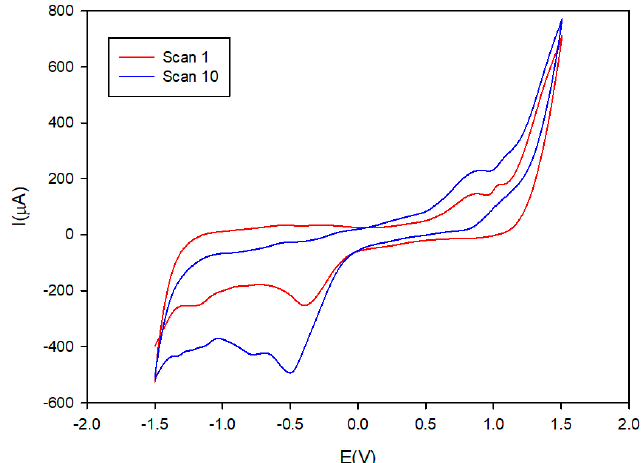
Figure 3. Comparison of the Cobalt (II) phthalocyanine/SPCE-Ink before (scan 1) and after (scan 10) the activation. Electrochemical activation consists of 10 repetitive voltammetric cycles at 50 mV·s − 1 between 1.5 and − 1.5 V using 10 mM H 2 O 2 in phosphate buffer (pH 7). After activation, electrodes were rinsed with deionized water and dried in air.